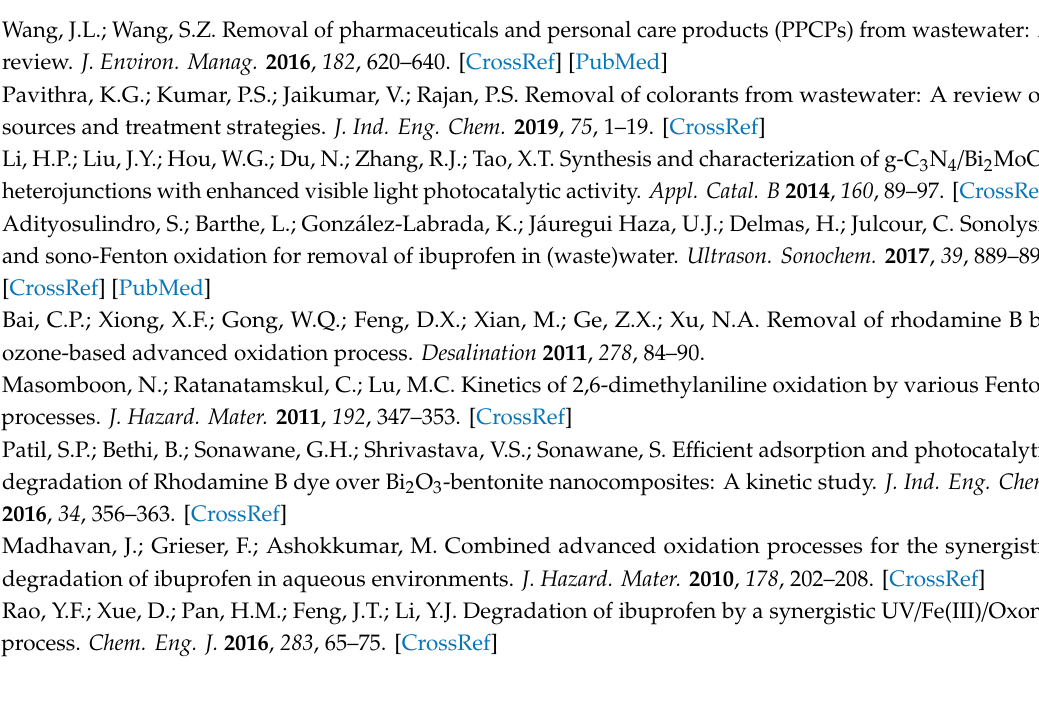
Figure S1: ( A ) [H 2 O 2 ], ( B ) [Rh B] / [Rh B] 0 , and ( C ) ln ([Rh B] / [Rh B] 0 ) as a function of time in the presence of 1 g / L of the Cu / Al 2 O 3 / CN composite at room temperature. Reaction conditions: [Rh B] 0 = 20 mg / L, [H 2 O 2 ] 0 = 10 mM, V = 100 mL, pH 4.9 (unadjusted); Figure S2: [Rh B] / [Rh B] 0 as a function of time in nonfiltered Cu / Al 2 O 3 / CN suspensionandfiltratesobtainedatselectedtimeintervals. Reactionconditions: [catalyst] = 1g / L,[RhB] 0 = 20mg / L, [H 2 O 2 ] 0 = 10 mM, V = 100 mL, 25 ◦ C, pH 4.9 (unadjusted); Figure S3: C / C 0 as a function of time with di ff erent organic pollutants in the presence of 1 g / L of the Cu / Al 2 O 3 / CN composite. Reaction conditions: [dye] = 20 mg / L, [H 2 O 2 ] 0 = 10 mM, V = 100 mL, 25 ◦ C, pH 4.9 (unadjusted); Figure S4: HPLC chromatograms of samples extracted at di ff erent reaction times. Reaction conditions: [catalyst] = 1 g / L, [dye] = 20 mg / L, [H 2 O 2 ] 0 = 10 mM, V = 100 mL, 25 ◦ C, pH 4.9 (unadjusted); Figure S5: Mass spectrograms of the degradation products in sample extracted at 60 min in Rh B degradation.; Table S1: Comparison of the catalytic activities of the Cu / Al 2 O 3 / CN composite with other copper-based Fenton-like